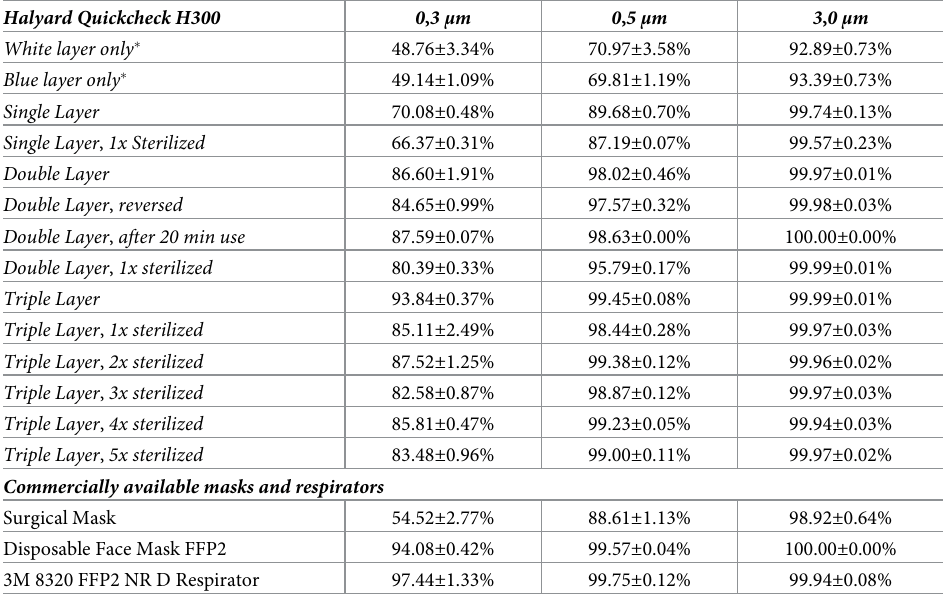
Table 1. Summary of the filter efficiency of the Quickcheck H300 material and commercially available masks, for the indicated particle sizes.